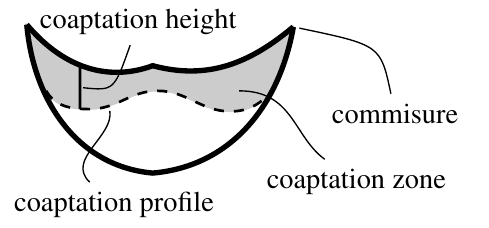
Figure 7. Coaptation characteristics for a